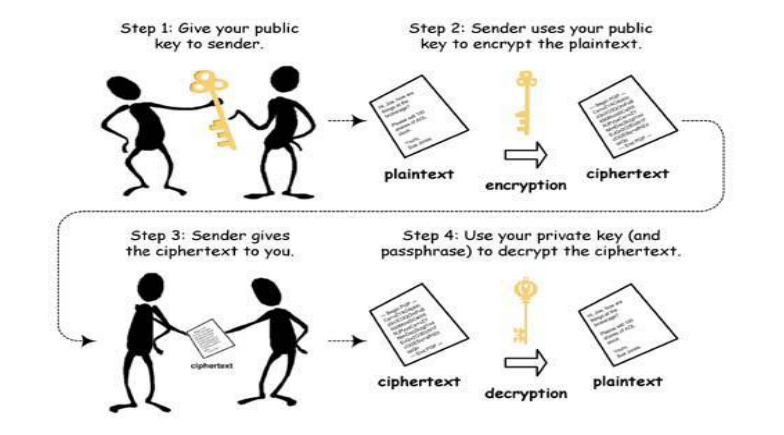
Fig. 3. Asymmetric-key